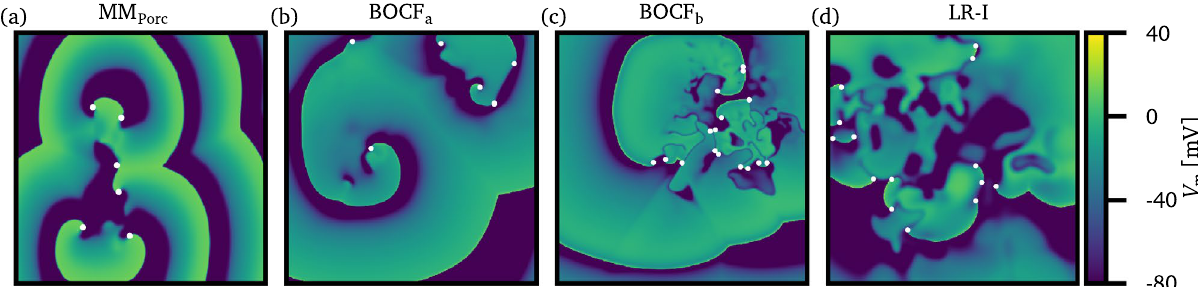
Figure 1. Exemplary snapshots of the membrane potential V m are shown for the three-variable minimal model MM Porc 27 ( a ), the Bueno-Orovio–Cherry–Fenton model BOCF a 28 ( b ) and BOCF b ( c ), and the Luo–Rudy-I model LR-I 29 ( d ), respectively. The organizing centers of spiral waves (phase singularities) are denoted as white